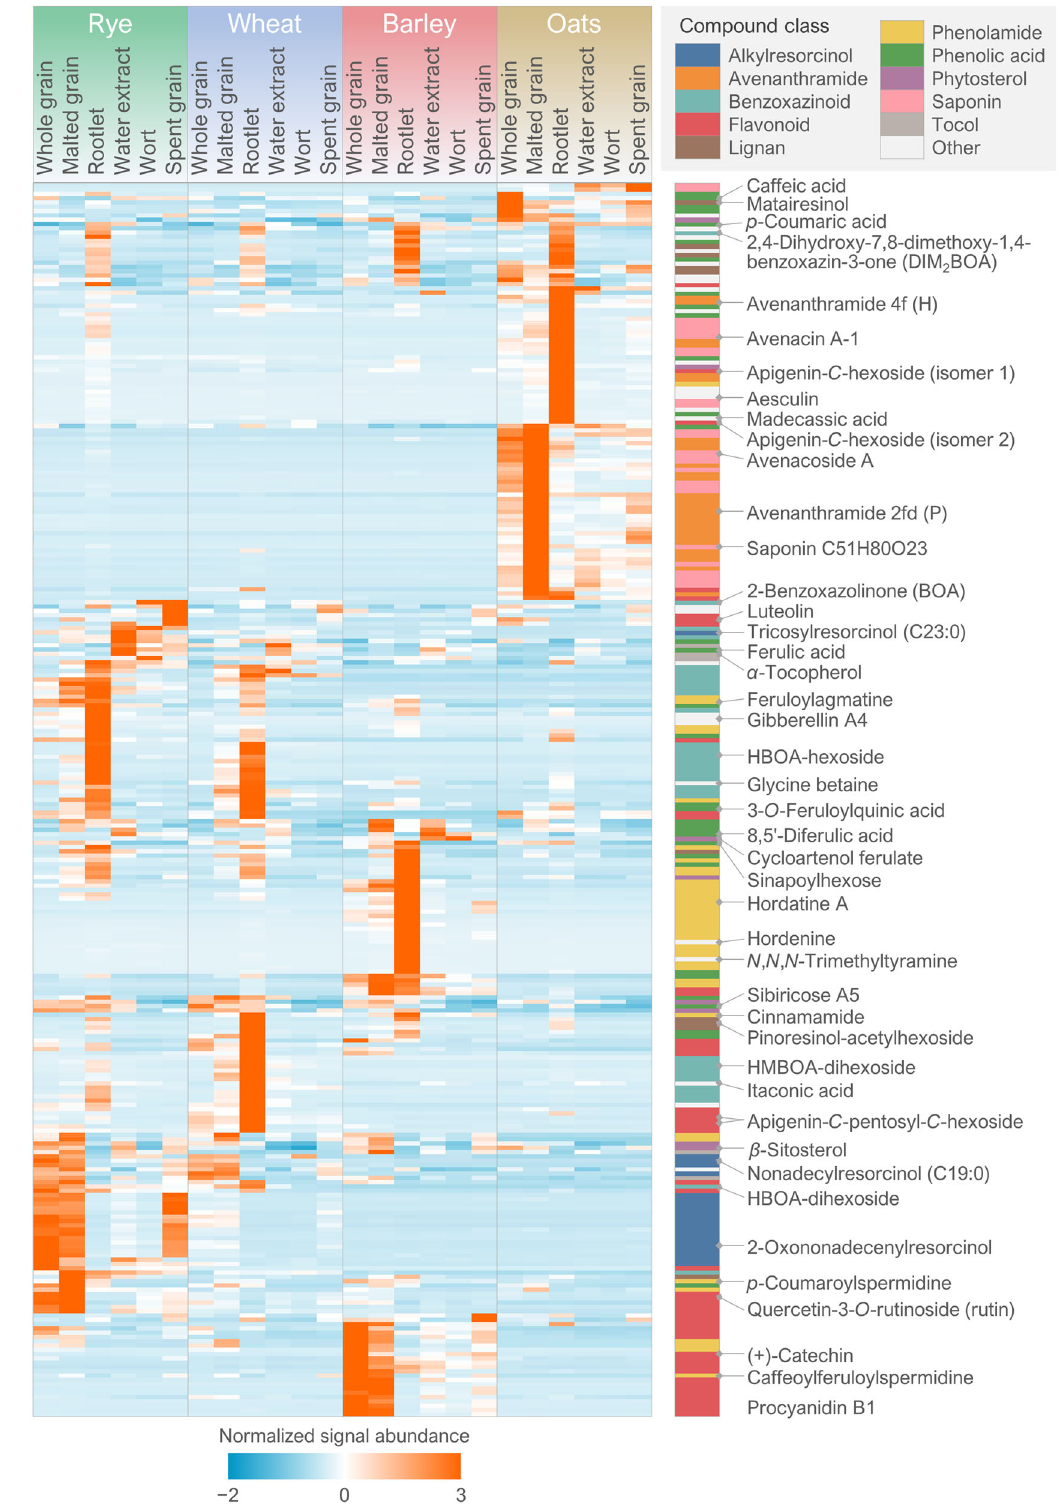
Fig. 3 Normalized phytochemical levels during malting. A heat map of the normalized signal intensities (as group averages) of all the annotated phytochemicals ( n = 285) in all the studied sample types. The chemical classi fi cation of each compound is given as a color code. Examples of individual phytochemicals belonging to the various classes, including those discussed in this paper, are highlighted from the heat